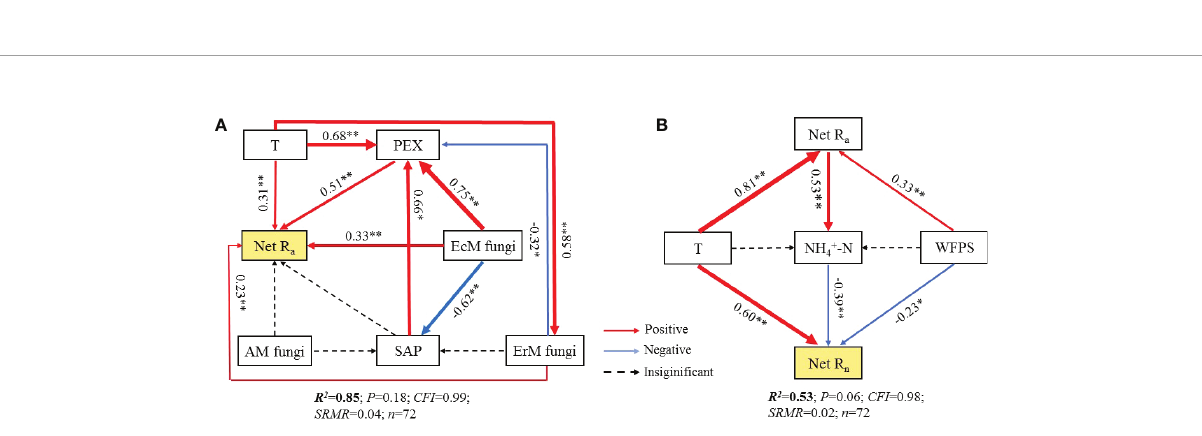
FIGURE 6 Structural equation models (SEM) analysis depicting the effects of soil PEX (peroxidase) activity, soil fungal functional guilds and soil environment key factors on soil net ammoni fi cation rate (Net R a ) (A) and soil net nitri fi cation rate (Net R n ) (B) . T, temperature; WFPS, water- fi lled pore space. EcM fungi, ectomycorrhizal fungi; AM fungi, arbuscular mycorrhizal fungi; ErM fungi, ericoid mycorrhizal fungi; SAP, unde fi ned